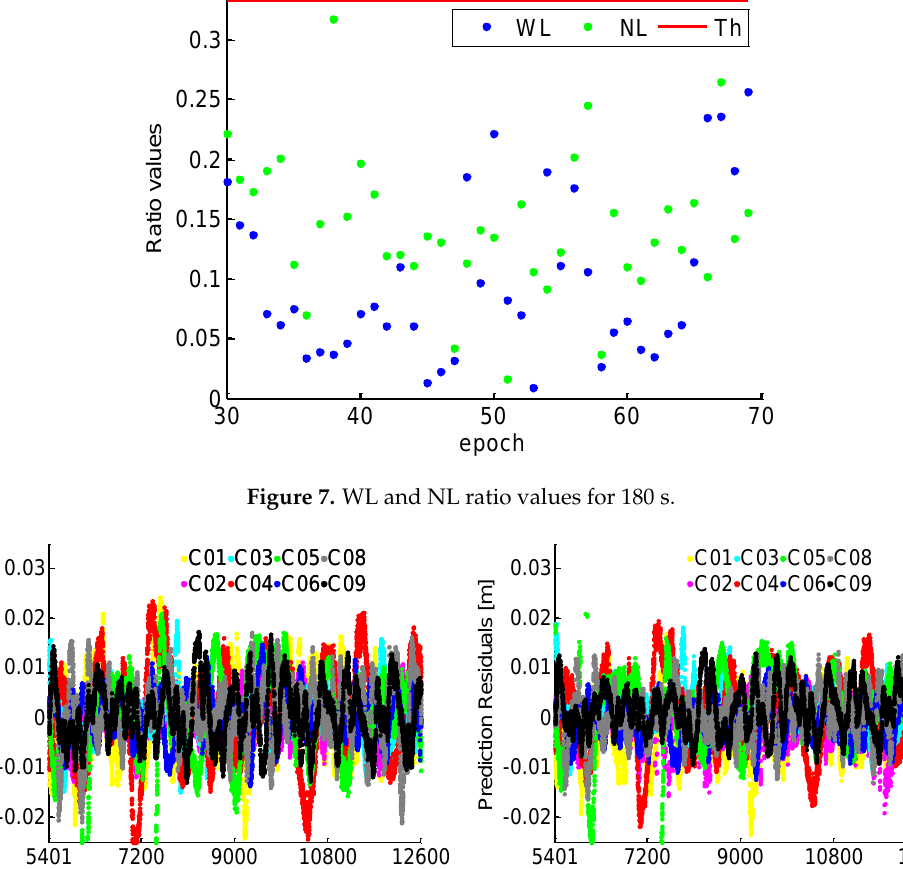
Table 2. RMS of prediction residuals based on TRIM in different data gaps. Interval RMS